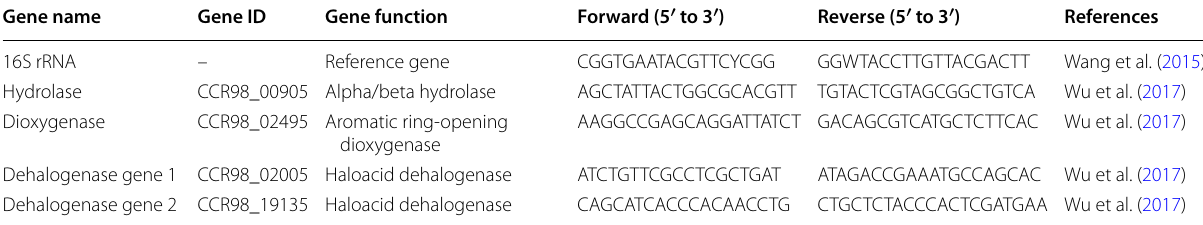
Table 1 Genes and corresponding primers for the real-time